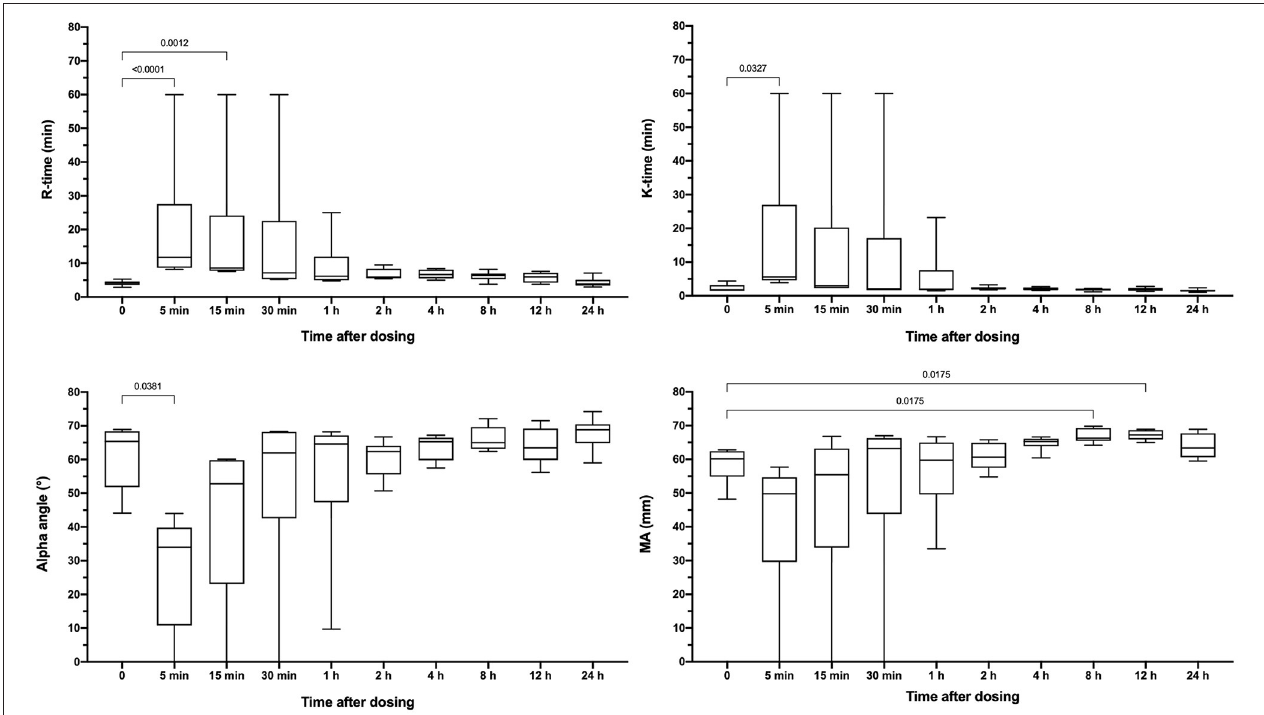
FIGURE 4 | Box-whisker plots representing the reaction time (R-time), clot formation time (K-time), clot formation angle (alpha) and maximum amplitude (MA) from tissue-factor activated thromboelastography tracings. Partial thromboplastin time (aPTT) values following oral administration of apixaban (0.2 mg/kg). Data are presented as median (middle line), 25–75% percentile (box) and min-max (whiskers) for each time point. Comparisons between baseline and subsequent time points were conducted using the Friedman test with Dunn’s post-hoc correction for multiple comparisons. Only those comparisons that attained P < 0.05 are